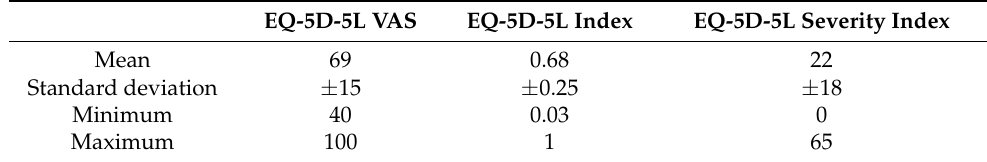
Table 2. EQ-5D-5L